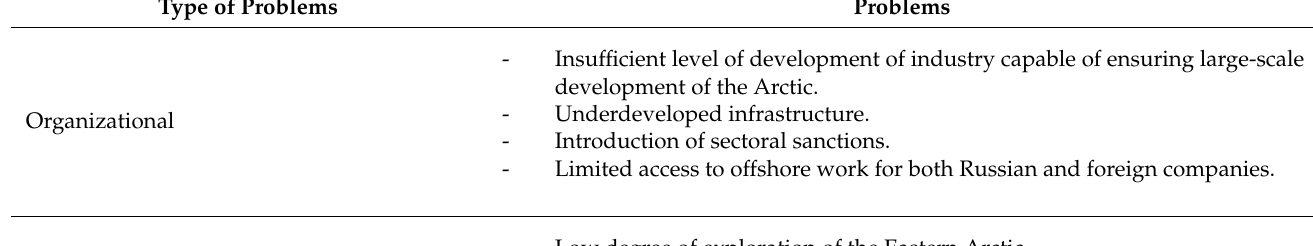
Table 3. Problems of development of hydrocarbon deposits in the Arctic (created by the authors, based on [24,27,74–78]). Type of